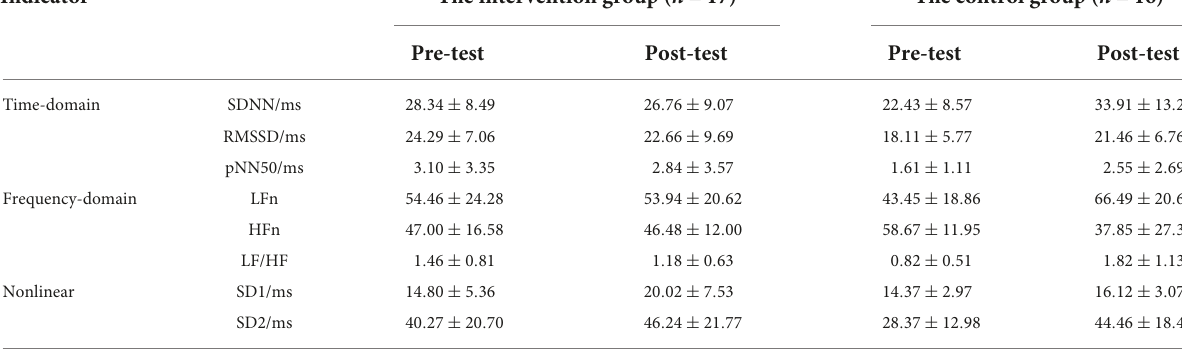
TABLE 4 HRV results of pre-test and post-test in the two groups of patients.